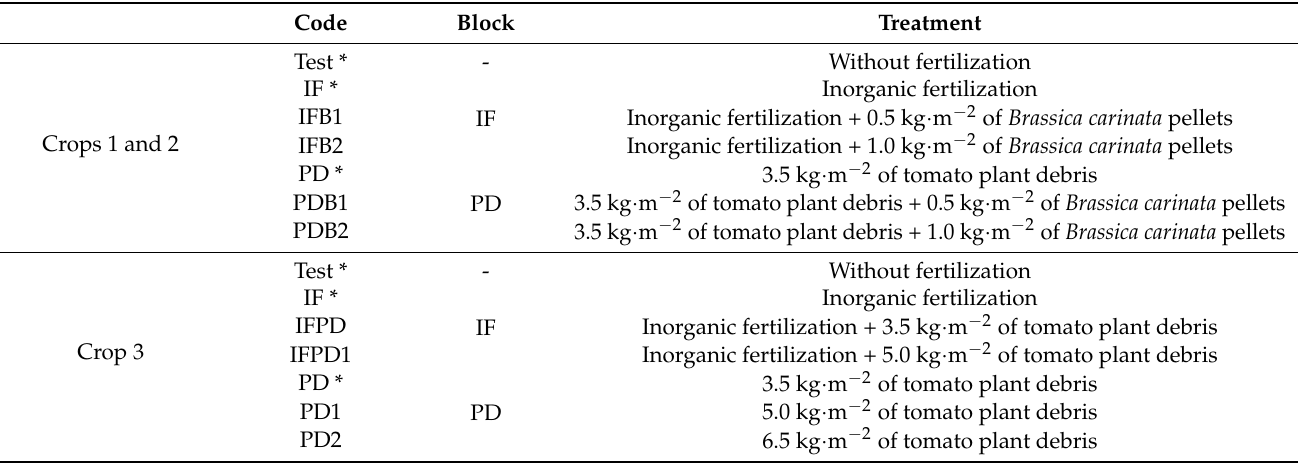
Table 2. Treatments applied to the greenhouse tomato crop during the research (September–April